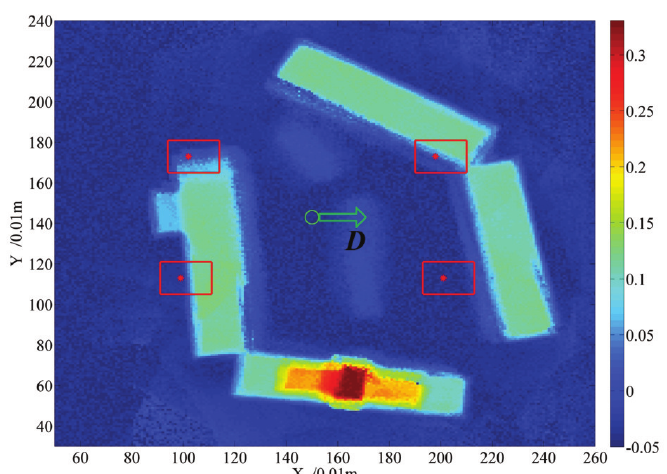
Figure 10. Four default footholds computed from the robot body center and moving direction, a region of candidate footholds around a default foothold is also marked using a red rectangle for each foot, respectively.